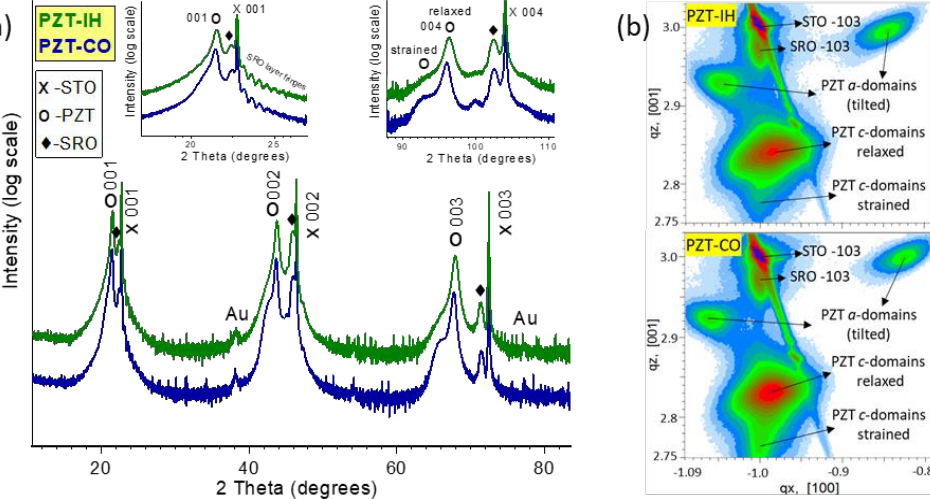
Figure 1. ( a ) The XRD patterns of the samples, showing in the insets details around the 001 and 004 lines of the substrate. ( b ) Reciprocal space mappings in the vicinity of the −103 node of the STO substrate.